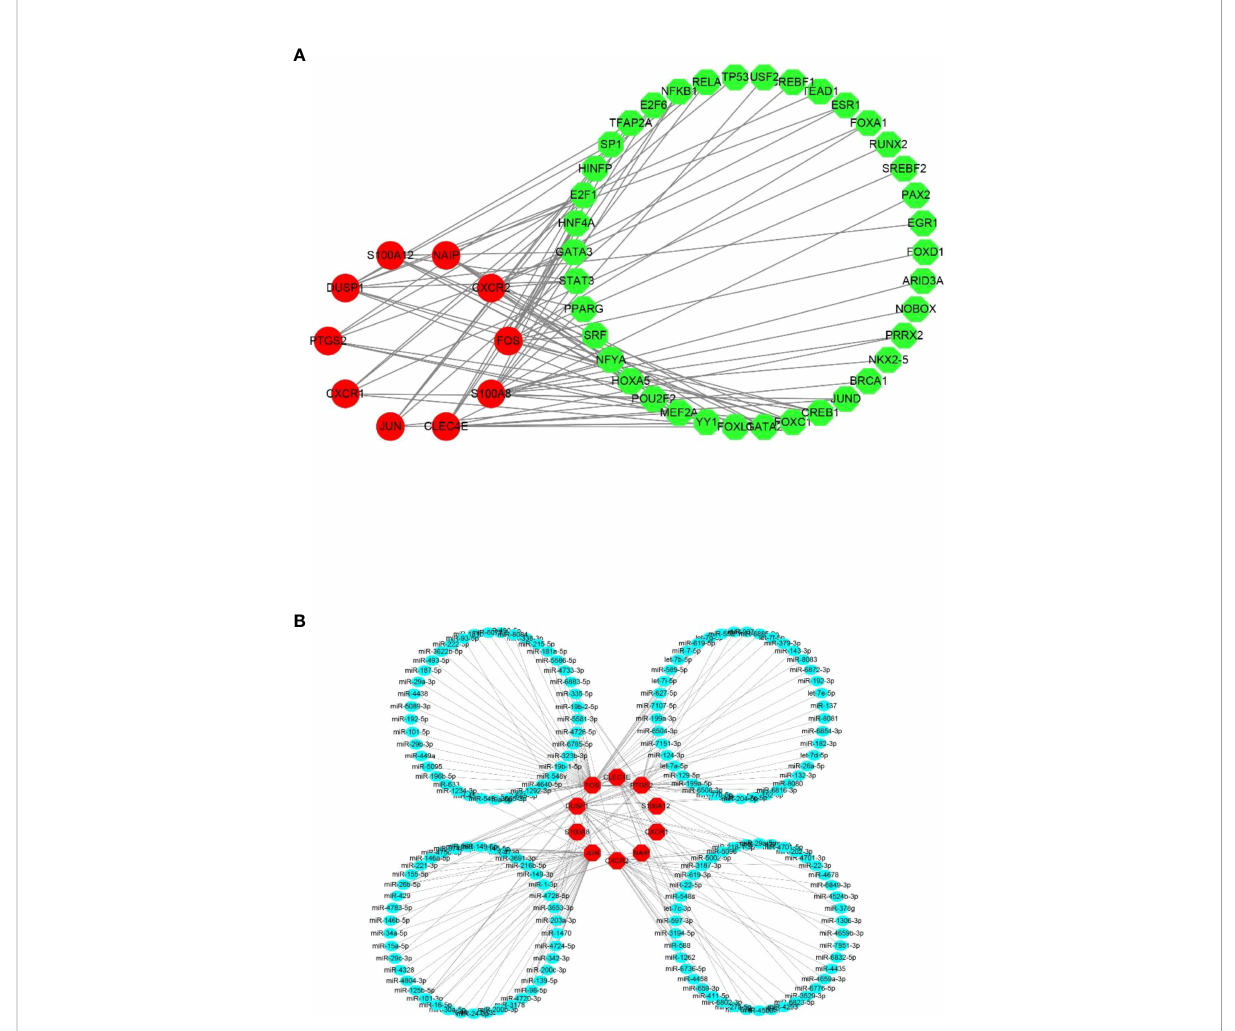
FIGURE 6 Potential regulatory molecules for the 10 hub CRGs. The red nodes depict the hub CRGs). (A) Ten hub CRGs and their interactions with potential transcription factors (TFs) based on the JASPAR database (49 nodes and 76 edges). (B) Ten hub CRGs and their interactions with potential miRNAs based on the miRTarBase database (175 nodes and 189